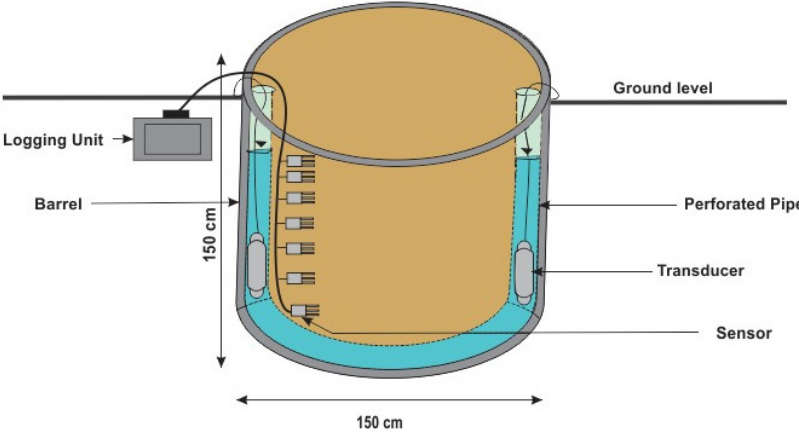
Figure 3. Schematic diagram of the setup to monitor water level, temperature and soil moisture gradients.